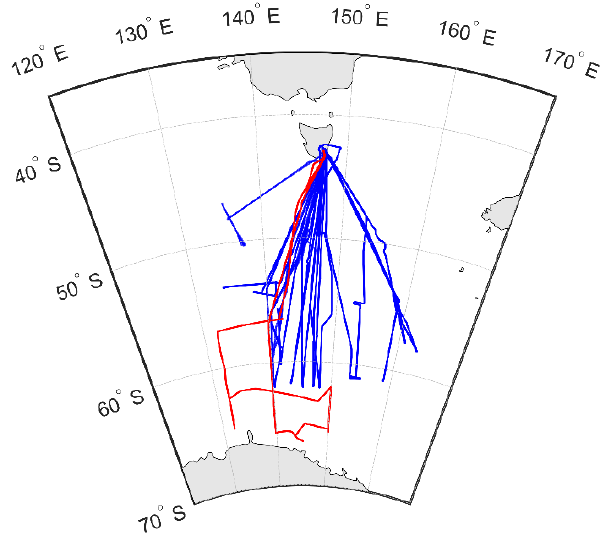
Figure 1. SOCRATES and CAPRICORN-2 study region. Blue and red lines represent the SOCRATES flight tracks and CAPRICORN- 2 R/V Investigator tracks,